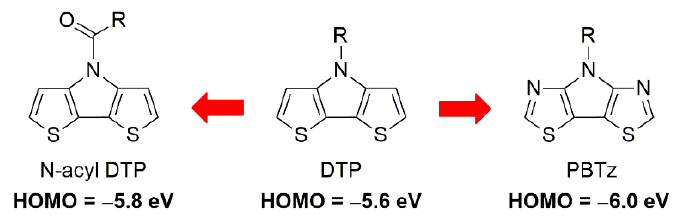
Figure 2. Approaches to stabilize the HOMO of DTP.